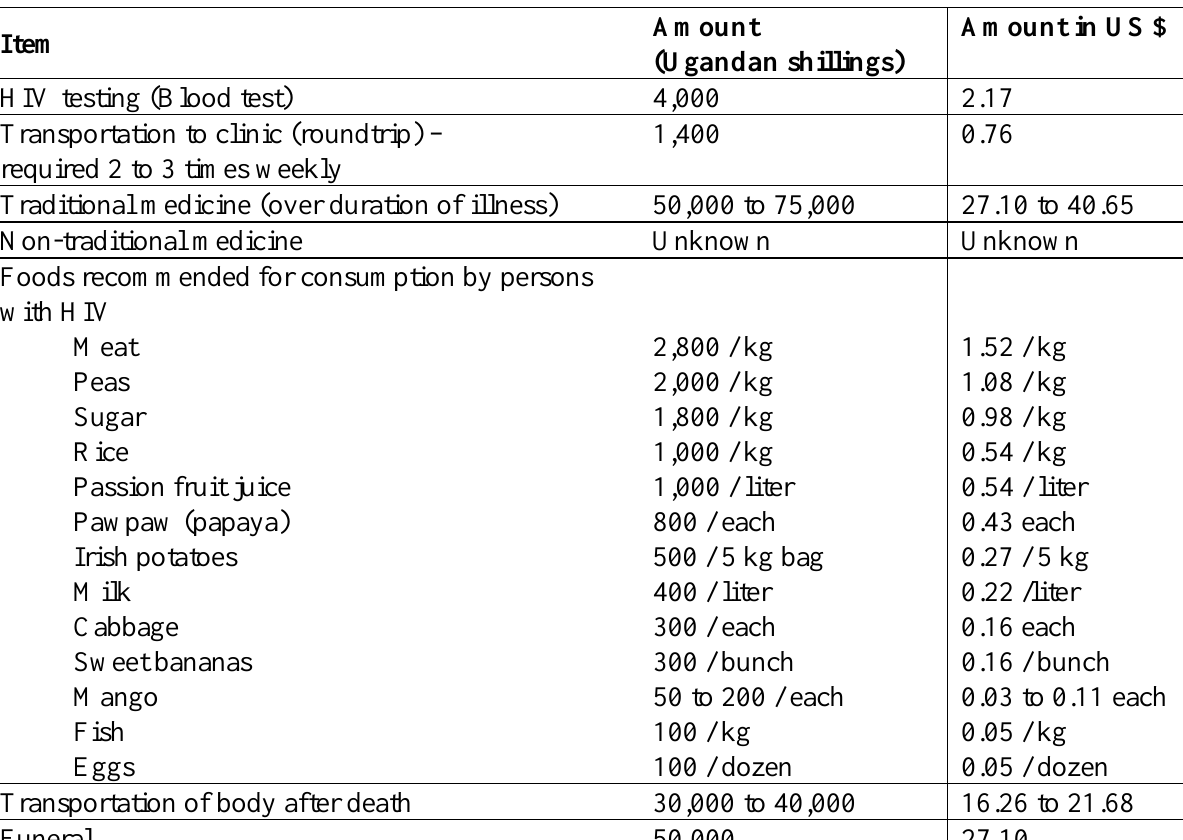
Table 2. Estimated medical and food expenses at time of interview on June 10,